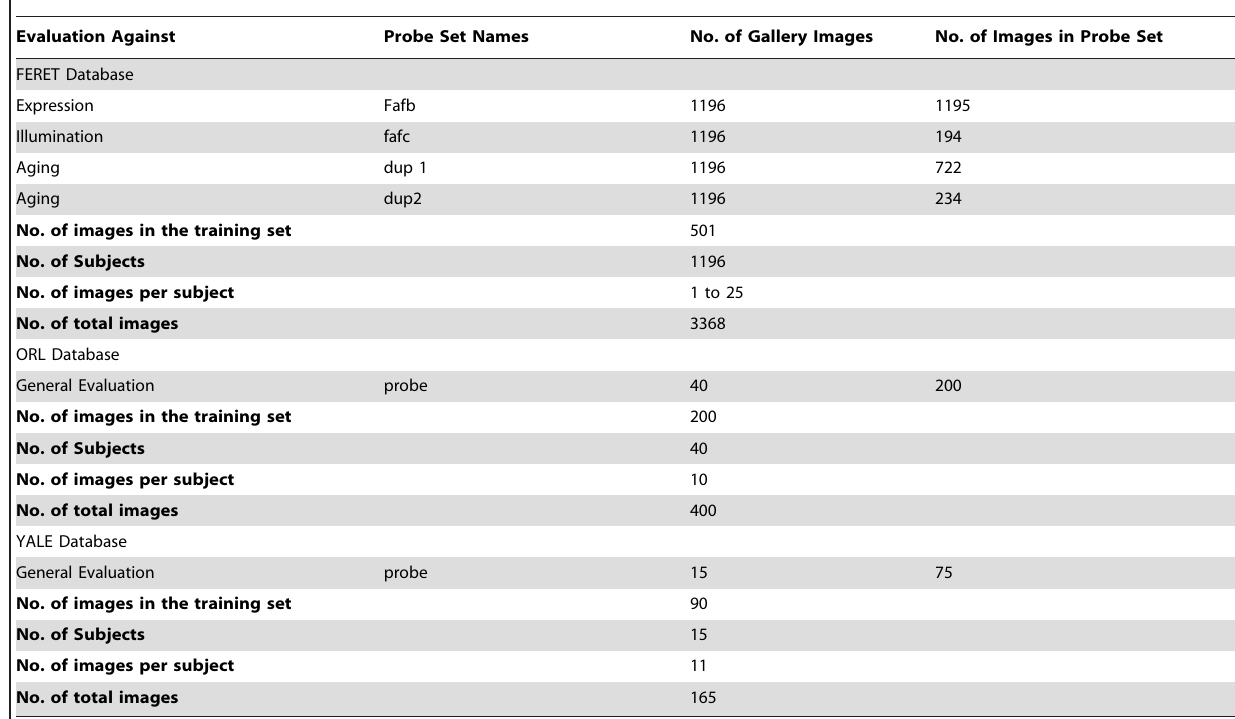
Table 3. Databases, training and test set